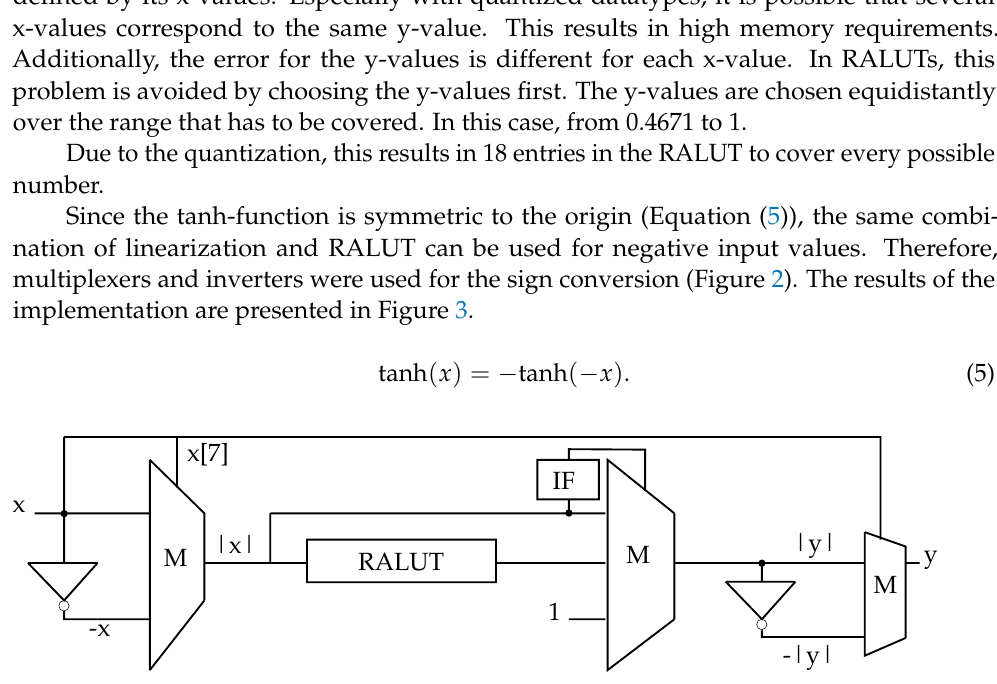
of the input x choosing either a linearization, RALUT or border x | |